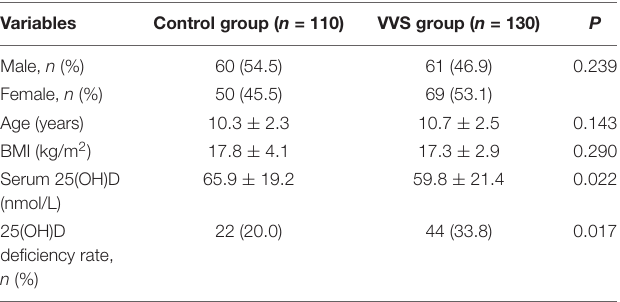
TABLE 1 | Clinical characteristics of healthy individuals and vasovagal syncope patients.